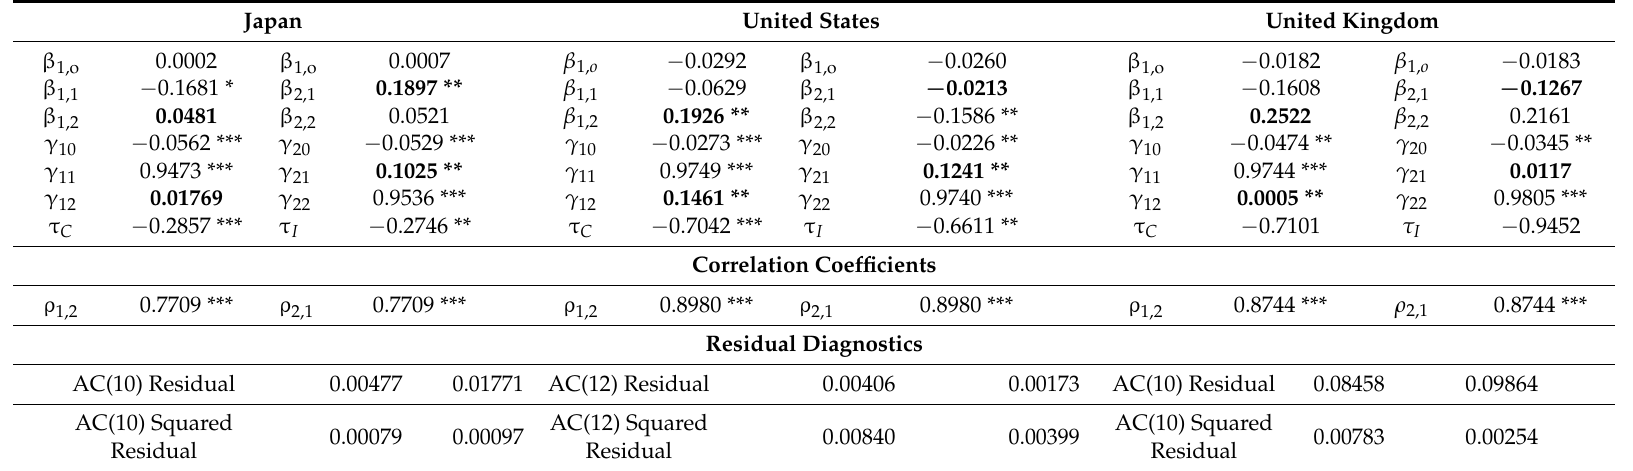
Table A3. Estimation from the bivariate VAR-EGARCH